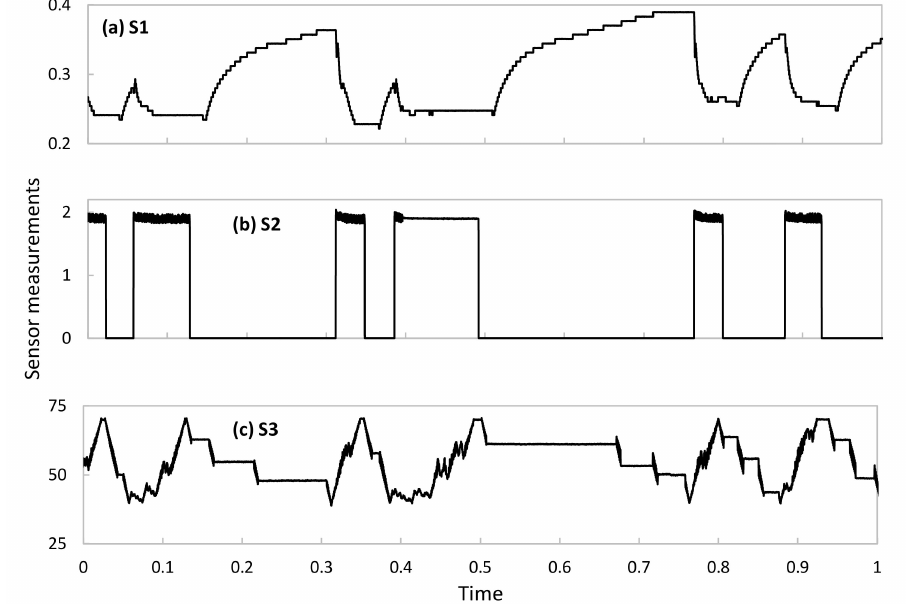
Figure 4. Example of the sensor data time series processed by each